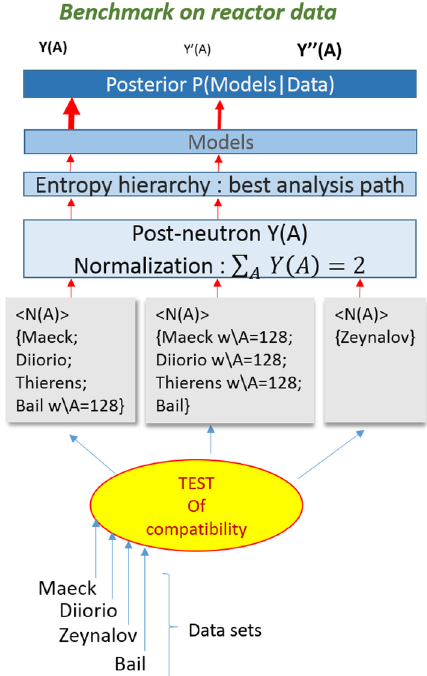
Fig. 9. Scheme of the analysis path: statistical test is needed to identify the compatible measurements per set and not only per mass. For all series, covariance matrices are de fi ned in order to take into account the different analysis paths. Final results represent all the solutions given by the microscopic data which will be compared to integral measurements or cumulative mass